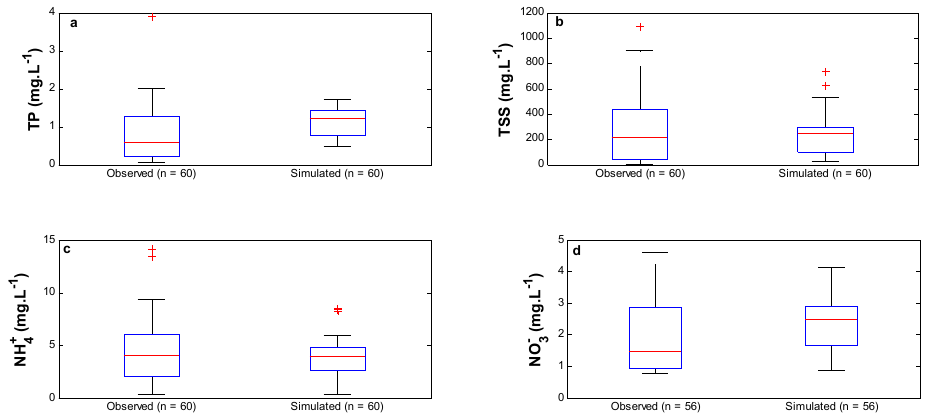
Figure 3. Runoff water quality in the Ressaca-Sarandi catchment: measured and simulated concentrations for ( a ) TP, ( b ) TSS, ( c ) NH 4 + and ( d ) NO 3 − . The horizontal red line is the median value; the blue box represents the interquartile range (IQR), the whiskers the lowest value still within 1.5 IQR of the lower quartile and the highest value still within 1.5 IQR of the upper quartile and red crosses the outliers.